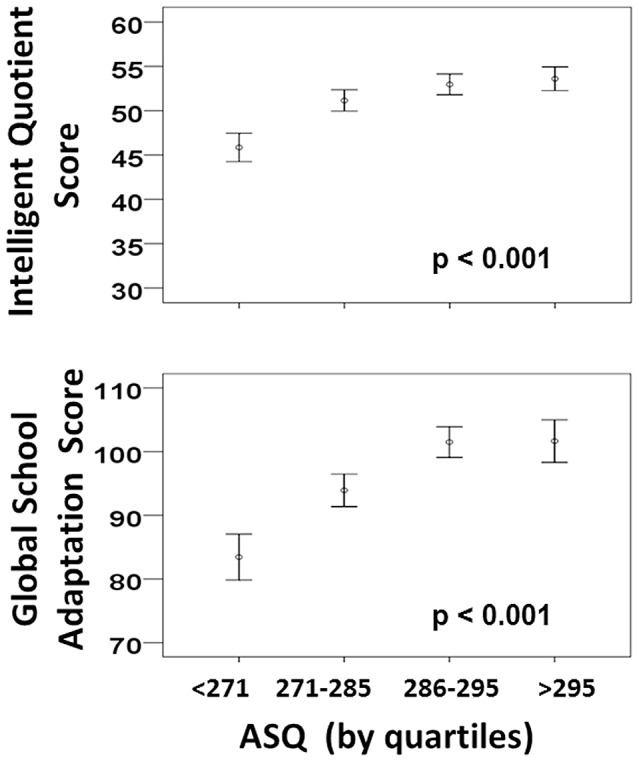
Correlations between global ASQ scores and full-scale IQ scores, and between global ASQ scores and GSA scores.